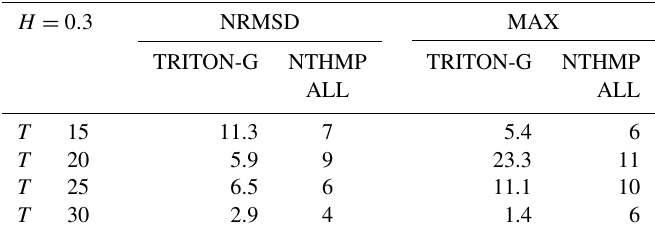
Table A2. Modeled surface profile errors with respect to laboratory experiments for case C H/d = 0 . 30 at times 15, 20, 25 and 30. Results from the NTHMP workshop model errors available are shown (ALL).